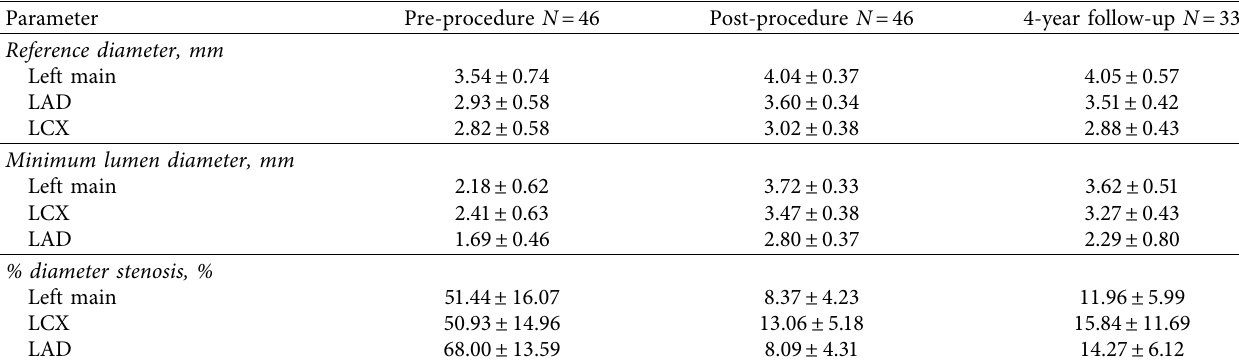
Table 3: Quantitative coronary angiography